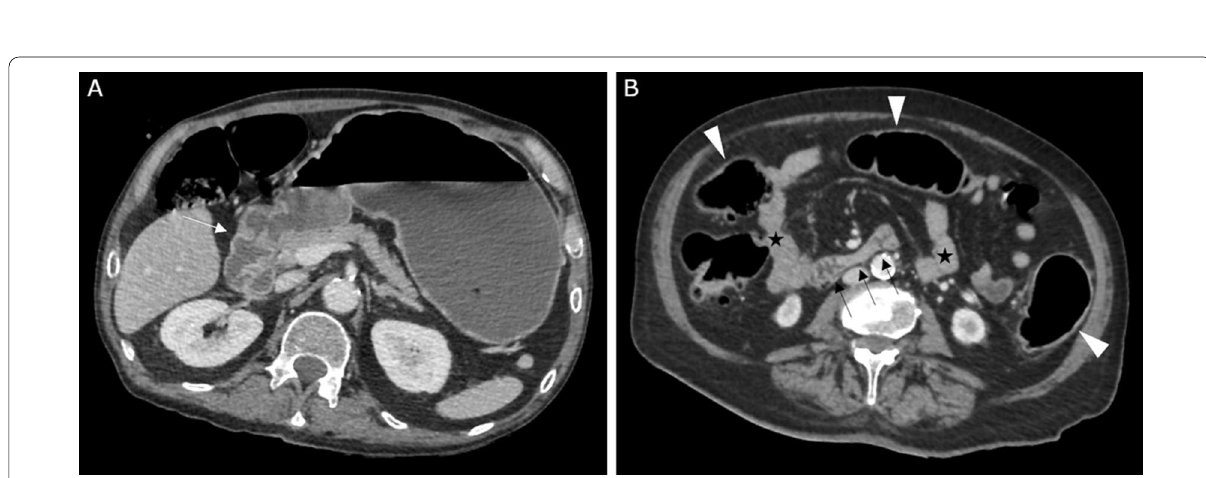
Fig. 16 Gastroparesis. Axial CT images (portal venous phase) at the level of the pyloroduodenal junction ( A ) and of the third part of the duodenum ( B ), showing a marked gastric dilatation upstream of the pyloroduodenal junction (white arrow), without any mechanical obstruction. There is no duodenal dilatation (black arrows), neither of the other parts of the small intestine (black stars). Note the mild aeric colic distention (black arrowheads)